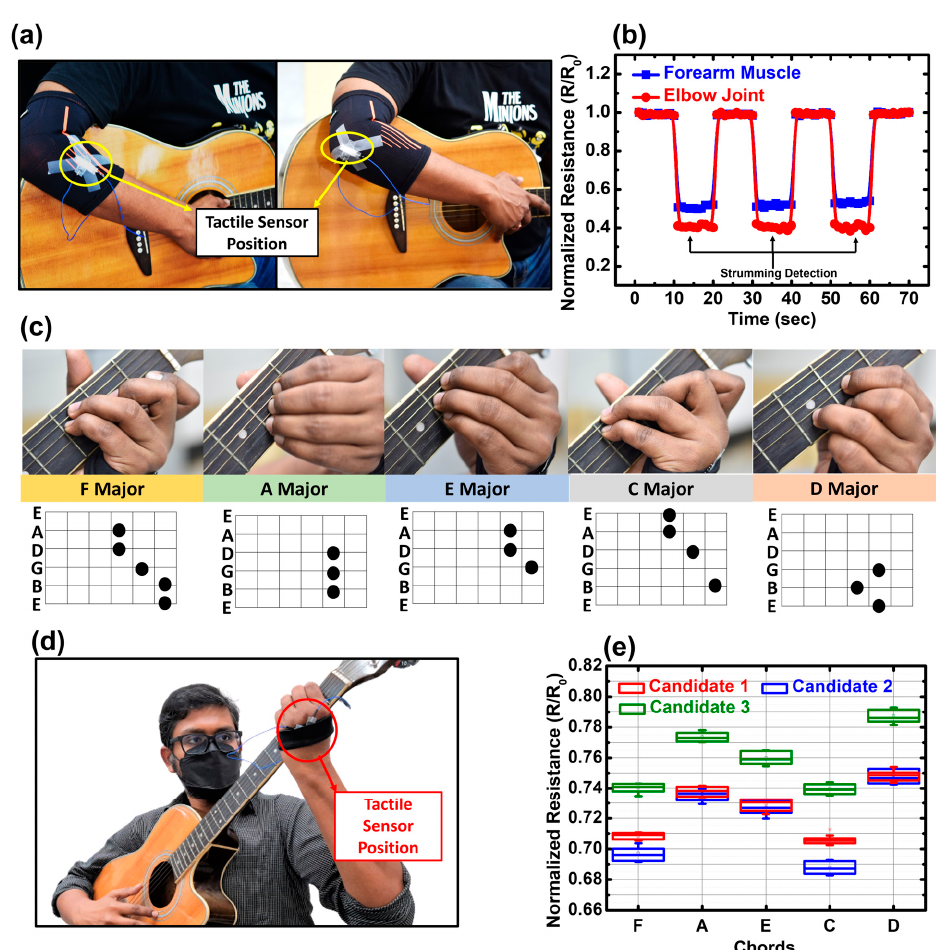
Figure 9. ( a ) Placement of tactile sensor on forearm and elbow joint with an arm wrap ( b ) obtained data for guitar strumming test ( c ) chord structure and holding pattern ( d ) measurement setup for chord progression detection test. The tactile sensor was attached with an arm wrap and worn around the left palm. The sensor was placed on the back side of the palm to detect the maximum strain while holding the chords ( e ) obtained data for three different candidates with different skill levels (beginner to professional). For detecting the guitar chord progression, the sensor was a tt ached in a smaller arm wrap and it was worn on the left palm. The chord structures and holding pa tt erns are presented in Figure 9c. The tactile sensor was placed on the opposite of the palm, as shown in Figure 9d, since while holding a chord, the maximum amount of strain is exerted by the movement of fi ngers and muscles on that particular location of the left hand. This process is common for all guitar players with di ff erent palm shapes and sizes. Three vol- unteers with di ff erent skills were selected for this demonstration and they were asked to hold fi ve di ff erent chords, i.e., F, A, E, C and D. They wore the arm wrap on their palm